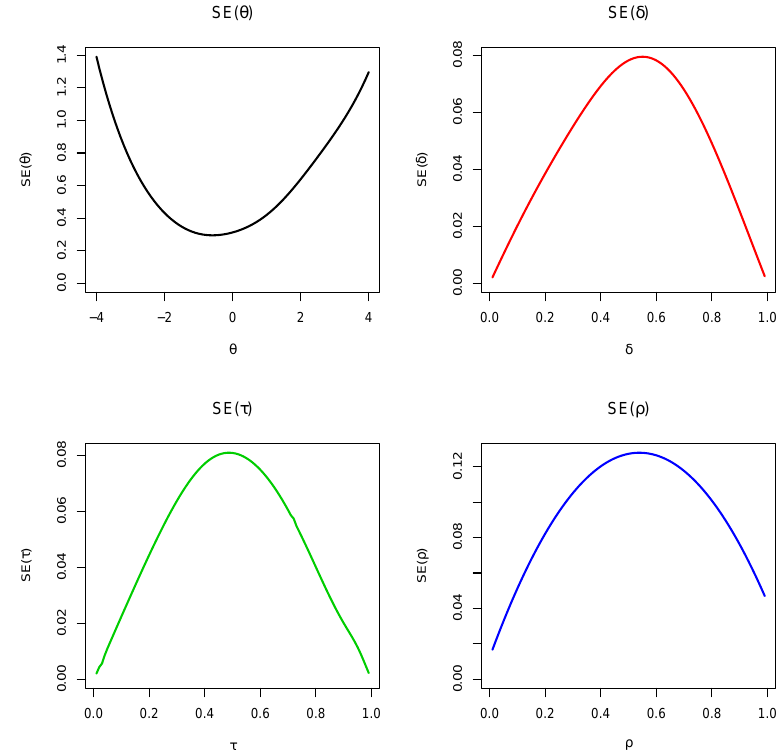
Figure 5. Conditional standard error functions for the logit score θ ( upper left ), the delta score δ ( upper right ), the true score τ ( lower left ), and the rank score ρ ( lower right ) for the PISA 2006 reading